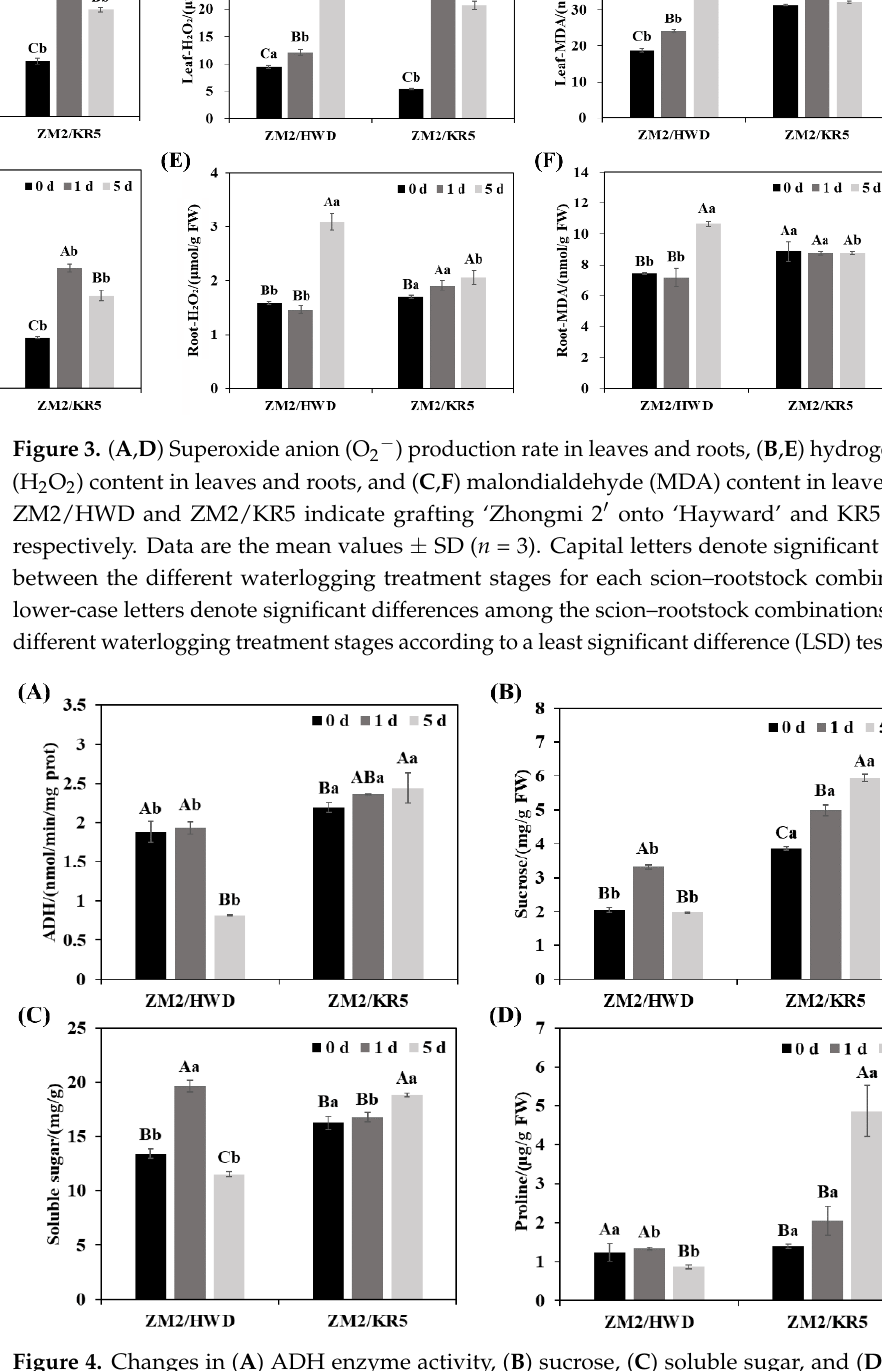
Figure 4. Changes in ( A ) ADH enzyme activity, ( B ) sucrose, ( C ) soluble sugar, and ( D ) proline in the roots of different scion – rootstock combinations under waterlogging stress. ZM2/HWD and ZM2/KR5 indicate grafting ‘ Zhongmi 2 ′ onto ‘ Hayward ’ and KR5 rootstocks, respectively. Data are the mean values ± SD ( n = 3). Capital letters denote significant differences between the different waterlogging treatment stages for each scion – rootstock combination, and lower-case letters denote significant differences among the scion – rootstock combinations within the different waterlogging treatment stages according to a least significant difference (LSD) test ( p ≤ 0.05).